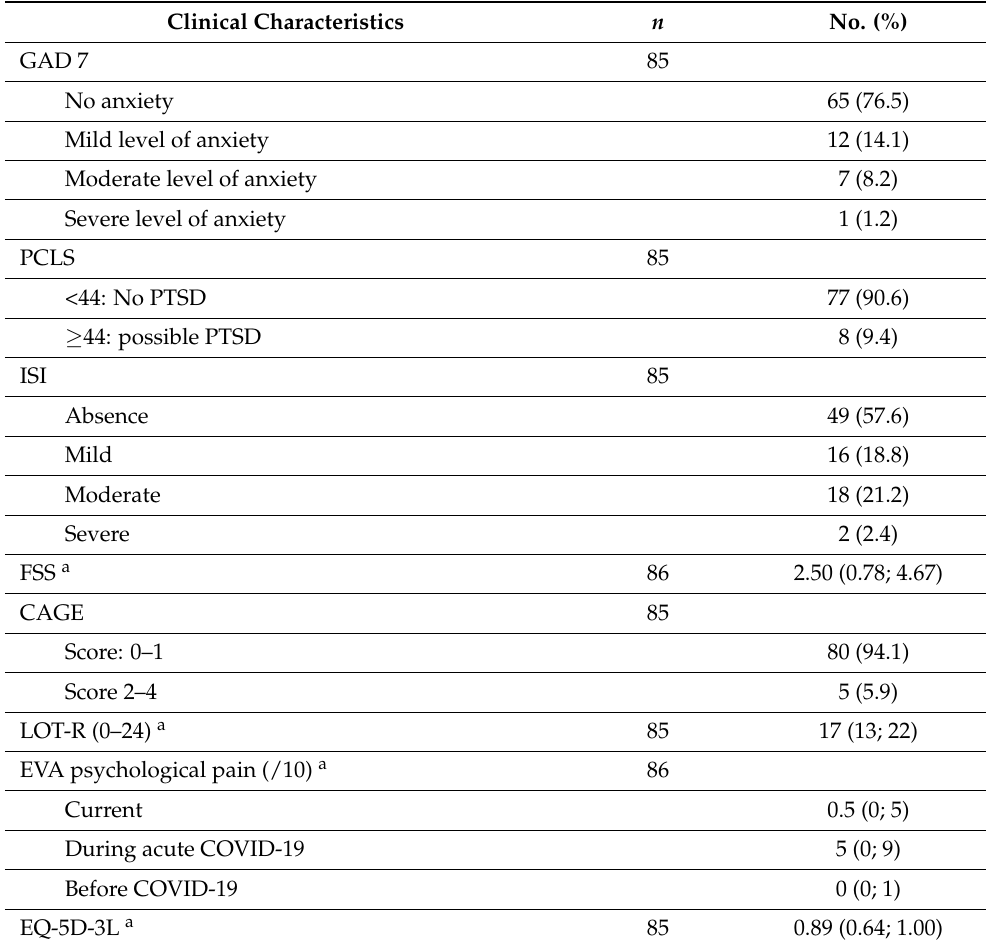
Table 2. Cont. Clinical